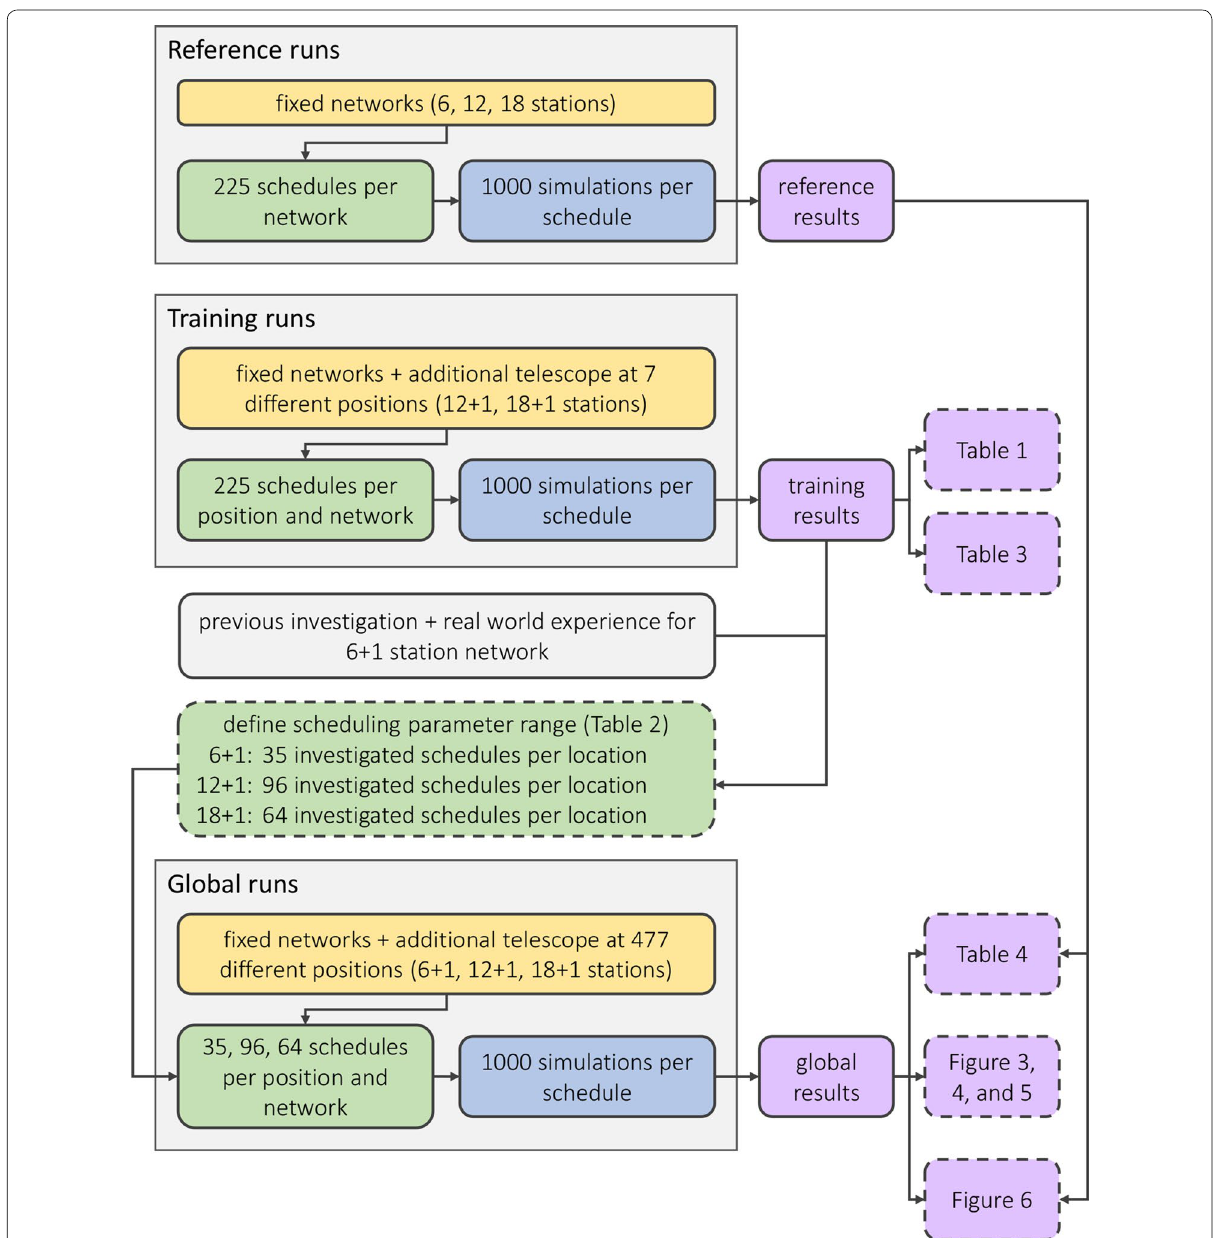
Fig. 1 Flowchart of method used in this study. Orange boxes, network definitions; green boxes, scheduling-related information; blue boxes, simulation-related information; purple boxes, results. Dashed boxes highlight results visualized in tables and figures in this